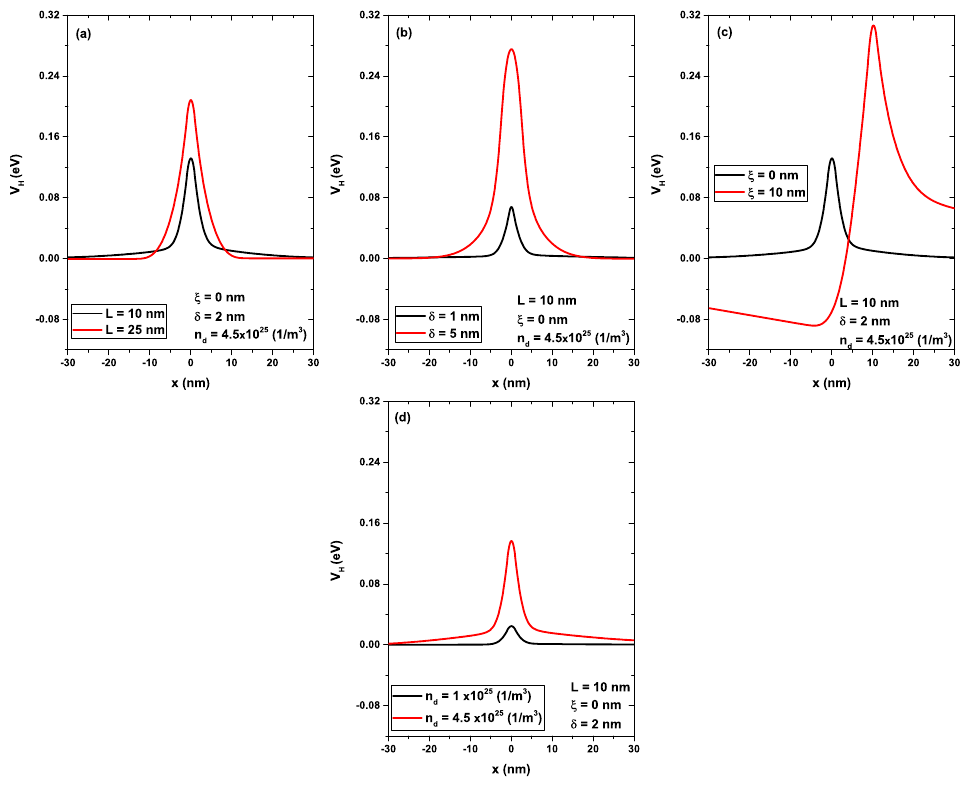
Figure 9. Self-consistent Hartree potential as a function of x -position. In ( a ) varying the L , in ( b ) varying the δ , in ( c ) varying the ξ , and in ( d ) varying the n d . In each case, when one parameter was changed, the others were set to L = 10nm, ξ = 0, δ = 2nm, and n d = 4.5 × 10 25 (1/m 3 ). Figure 10 shows the electron density as a function of the x -position: in (a) varying the L , in (b) varying the δ , in (c) varying the ξ , and in (d) varying the n d . In each case, when one parameter was changed, the others were set to L = 10 nm, ξ = 0, δ = 2 nm, and n d = 4.5 × 10 25 (1/m 3 ). Again, all four figures have been compared according to on the same scale. In Figure 10a, the electron density was compared for two different widths of the quantum well. Increasing L did not generate changes in the donor density; therefore, in magnitude, the density had remain fixed, as only its distribution changed. Therefore, for L = 10 nm, the electrons were more localized in the central region between − 5 nm < x < 5 nm. However, for L = 25 nm, the electrons lost the location and were now located in a much larger region, between − 12.5 nm < x < 12.5 nm, while the number of electrons per unit volume remained fixed. Figure 10b compares the electron density for two widths of the doped layer δ = 1 nm and δ = 5 nm. Since there was no change in the well width, the electrons were distributed mainly in the region between − 5 nm < x < 5 nm. The electron density magnitude was greater for δ = 5 nm since the donor density in n d = 4.5 × 10 25 (1/m 3 ), and these are distributed in a greater volume. Therefore, the number of charge carriers also had to increase, as clearly evidenced by comparing the red and black curves. Figure 10c compares the electron density for two different positions of the same doped delta layer: ξ = 0 and ξ = 10 nm, located 5 nm to the right of the edge of the well. For ξ = 0, once again, the electrons were distributed inside the GaAs well, while for ξ = 10 nm, most of the electrons were already in the AlGaAs region located in the well that had been generated by the doped delta layer. Although a portion of the electrons remained evenly balanced inside the initial well, this distribution was due to the well generated by the delta layer having a slightly greater width than the initial well that it had been modified by the Hartree potential; since this one was sharper, the electrons tended towards the region of least confinement (see Figure 7c). Finally, Figure 10d compares the electron density for two different donor densities in the delta layer n d = 1.0 × 10 25 (1/m 3 )